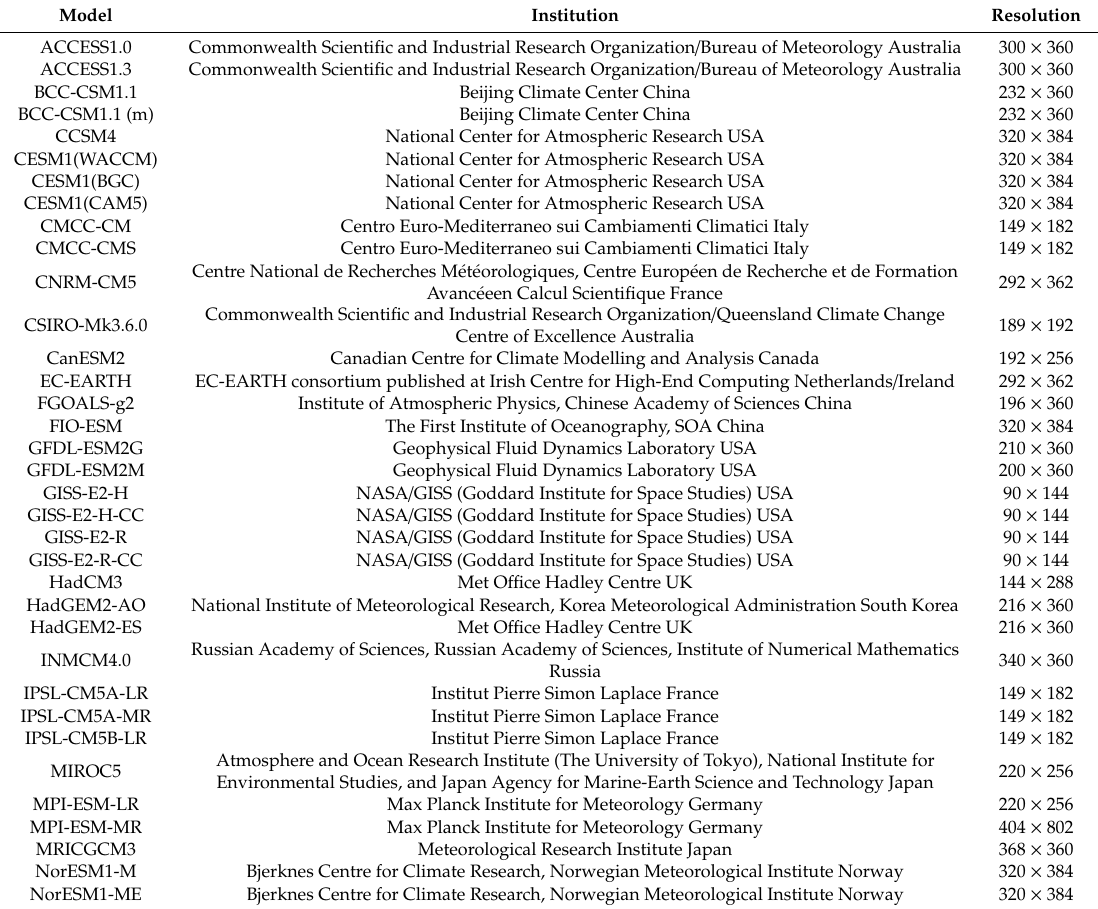
Table 1. List of the fifth Coupled Model Intercomparison Project (CMIP5)